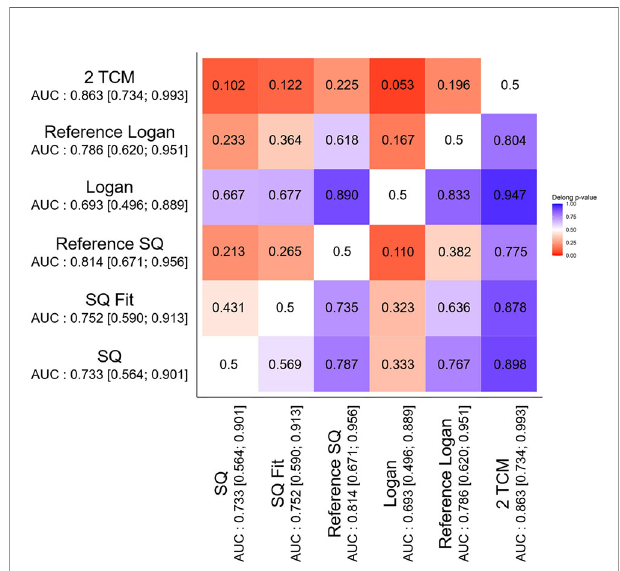
FIGURE 2 | Heatmap of the p -values for one-sided comparison of superiority pairwise Delong tests of the AUC multivariate analyses performed for each dynamic model. AUC , area under the curve; SQ , semiquantitative model; SQ Fit , semiquantitative fi tting parameters; Reference SQ , reference semiquantitative model; 2TCM , two-tissue compartmental model.